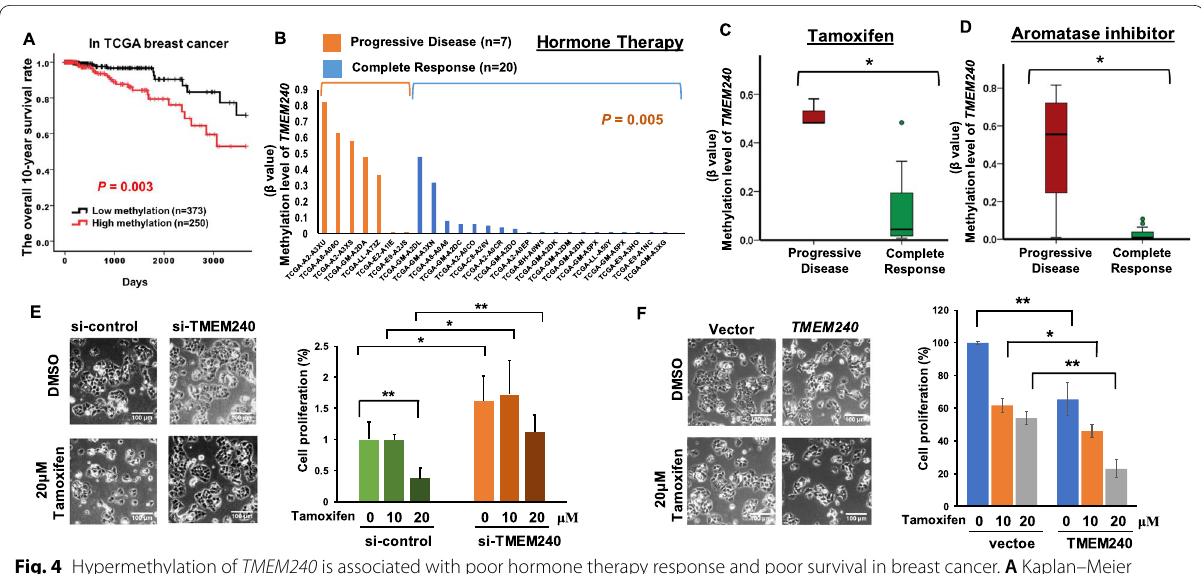
Fig. 4 Hypermethylation of TMEM240 is associated with poor hormone therapy response and poor survival in breast cancer. A Kaplan–Meier survival curves were used to compare 10‑year survival in breast cancer patients with low and high TMEM240 promoter hypermethylation. B Bar charts showing TMEM240 methylation levels in breast cancer patients. Orange bar: breast cancer patients with progressive disease after hormone therapy; blue bar, breast cancer patients with complete response after hormone therapy. C , D Box plots of TMEM240 methylation levels in patients with complete response or progressive disease after tamoxifen treatment ( C ) or aromatase inhibitor treatment ( D ). E , F Cell proliferation assays were performed in T47D cells treated with tamoxifen after si‑ TMEM240 transfection ( E , right) or pMyc‑DDK‑h TMEM240 plasmid transfection ( F , right). Brightfield views ( E – F , left) are presented to illustrate the cell morphology